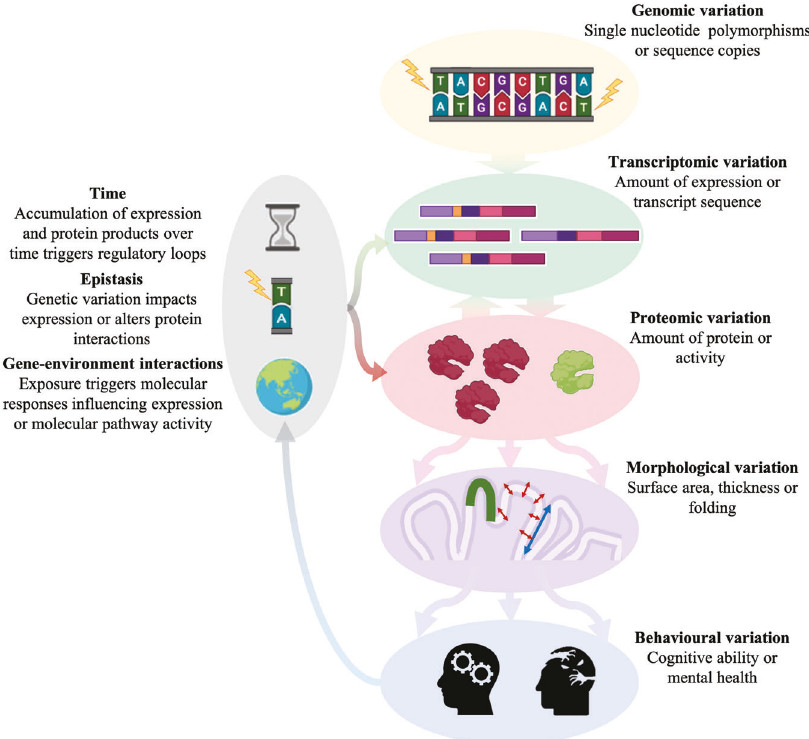
Fig. 3 Visualization of the pathway from gene to brain to behaviour, re fl ecting how variation at each level in fl uences the next. Biological complexity increases as we move further down, away from the direct effects of genetic variation, given the accumulation of in fl uences. The wide range of measures we use to study complex traits, be it cortical morphology or behavior, can be further split into more fi ne-grained measures capturing additional levels of organization, e.g., total surface area into regional measures, or diagnoses into symptoms. The complex relations and hierarchical structure ensure there is extensive pleiotropy between such traits, horizontally and vertically